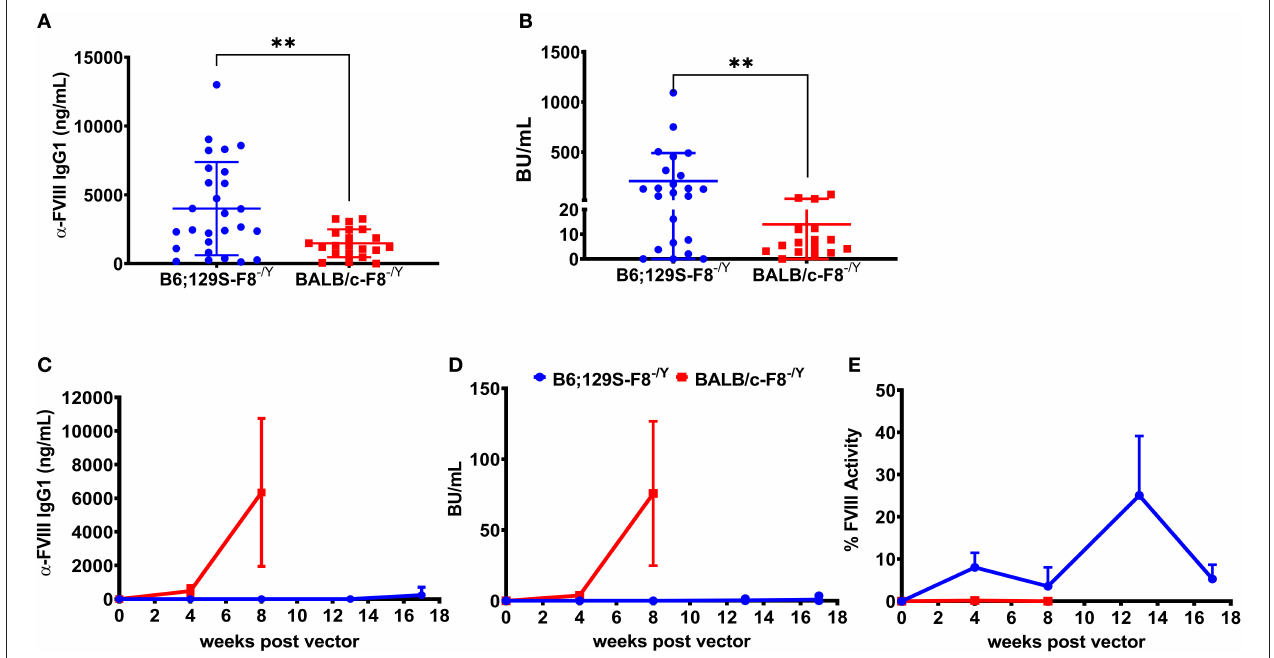
FIGURE 1 | Differential immune responses to BDD-FVIII protein in hemophilia A mice on different genetic backgrounds when delivered as recombinant protein or expressed in hepatocytes. Hemophilia A mice on B6;129 ( n = 27) or BALB/c ( n = 21) backgrounds received 4 weekly IV injections of 1 IU BDD-FVIII and plasma was collected at week 5 to measure anti-FVIII IgG1 levels (A) and Bethesda inhibitor titers (B) . In some animals we were unable to measure Bethesda inhibitors due to technical issues. Hemophilia A mice on 129;B6 or BALB/c backgrounds ( n = 4 per strain) were IV injected with 1 × 10 11 vg AAV8-ApoE-hAAT- coF8 vector and followed over time for anti-FVIII IgG1 levels (C) , Bethesda inhibitor titers (D) , and one-stage aPTT activity assay (E) . Mice were rechallenged with weekly IV injections of 1 IU BDD-FVIII protein for 4 weeks (C–E) . Statistical analysis of (A,B) was performed using 2-tailed Mann-Whitney test and (C–E) with multiple row T -test. A p < 0.05 was considered statistically significant, and indicated as follows: * p < 0.05, ** p < 0.01, *** p < 0.001, and **** p <